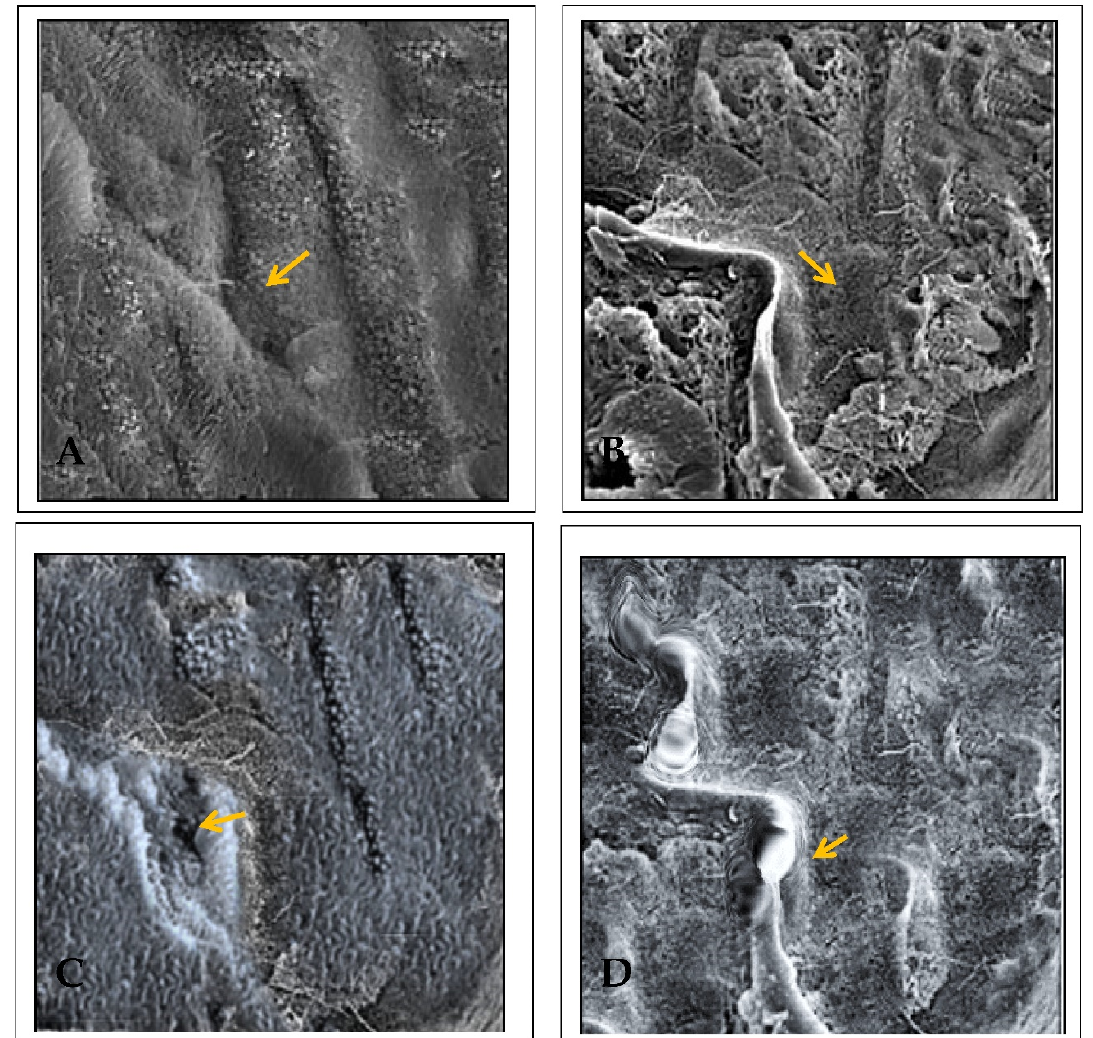
Figure 7. Scanning electron microscopy of the kidney (5000× magnification). ( A ) Control kidney shows the proximal convoluted tubules showed regions of tightly packed microvilli with a proximal tubule brush border. The arrow indicates the lumen and the arrow head indicates the microvilli. ( B ) Lead acetate (PbA; 30 mg/kg body weight (b.w.)) treated kidney shows sparse microvilli and pathological changes (arrow) in the brush border of proximal tubule cells. ( C ) N -acetylcysteine (NAC; 200 mg/kg b.w.) + PbA (30 mg/kg b.w.) treated kidney shows large microtubules and tightly packed microvilli. The tubule surface distortion is very much reduced. ( D ) Ethanolic extract of Celastrus paniculatus seeds (EECP; 800 mg/kg b.w.) + PbA (30 mg/kg b.w.) shows the tubules was lined with a simple columnar epithelium around a centralized lumen.